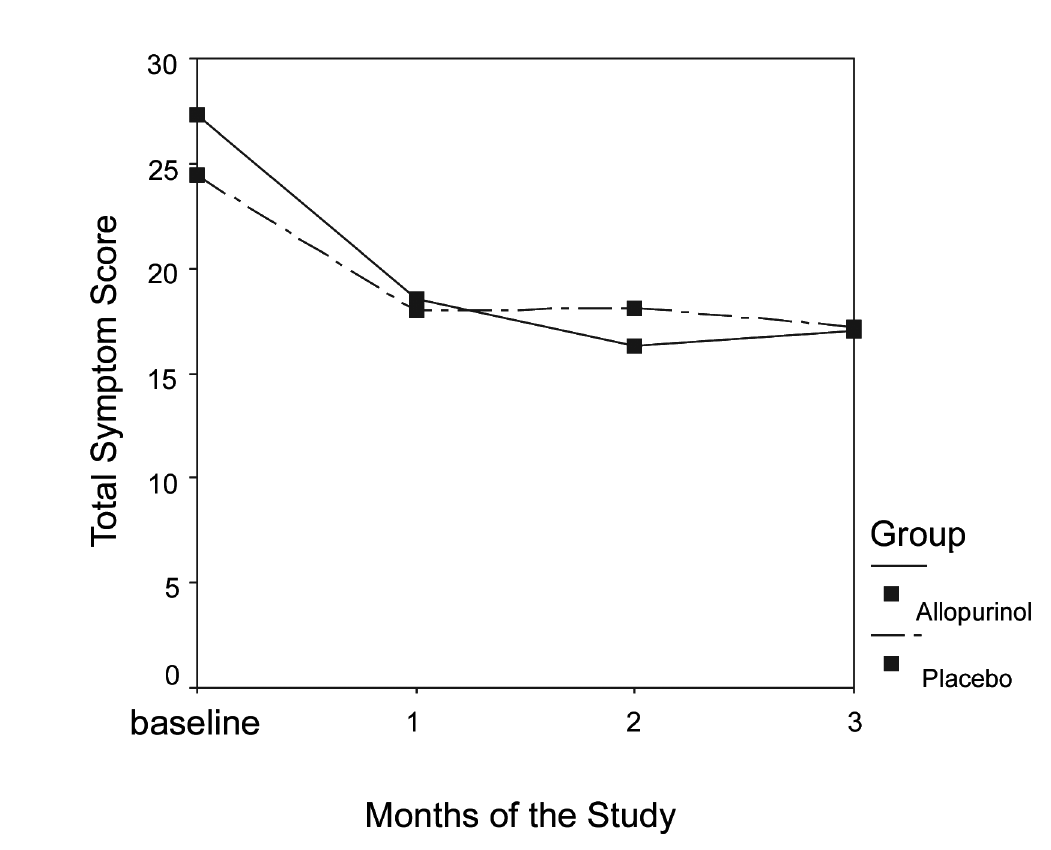
Figure 1 – Mean of total symptom score at different months of the study in the 2